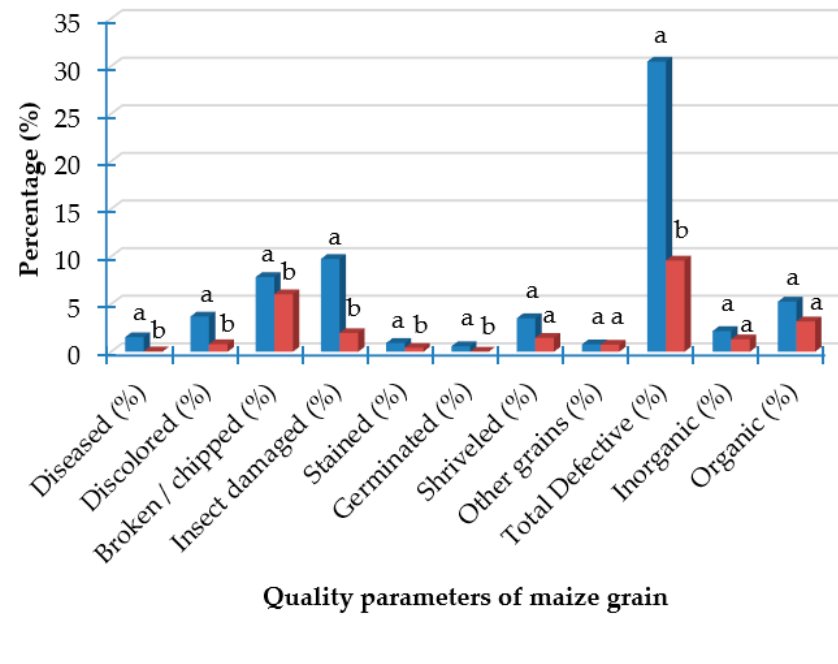
Figure 1. Percentage defects in grains stored in hermetic and PP bags. Means within the graph followed by the same letter are not significantly different at p < 0.05 (ANOVA: t -test).